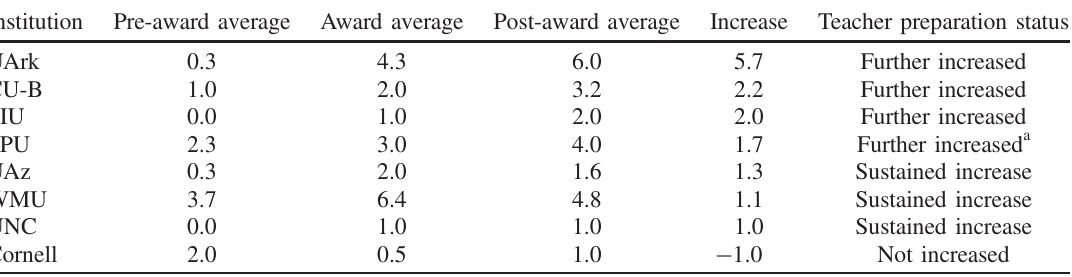
TABLE I. Number of physics teachers educated per year at PhysTEC legacy sites over the long term. “ Pre-award average, ” “ award average, ” and “ post-award average ” are the average number of physics teachers educated per year before, during, and after the PhysTEC award, respectively. “ Increase ” denotes the amount by which the post-award average exceeds the pre-award average. Teacher preparation status is “ sustained ” for sites whose increase is at least 1.0, and “ further increased ” for sites whose increase is at least 2.0.